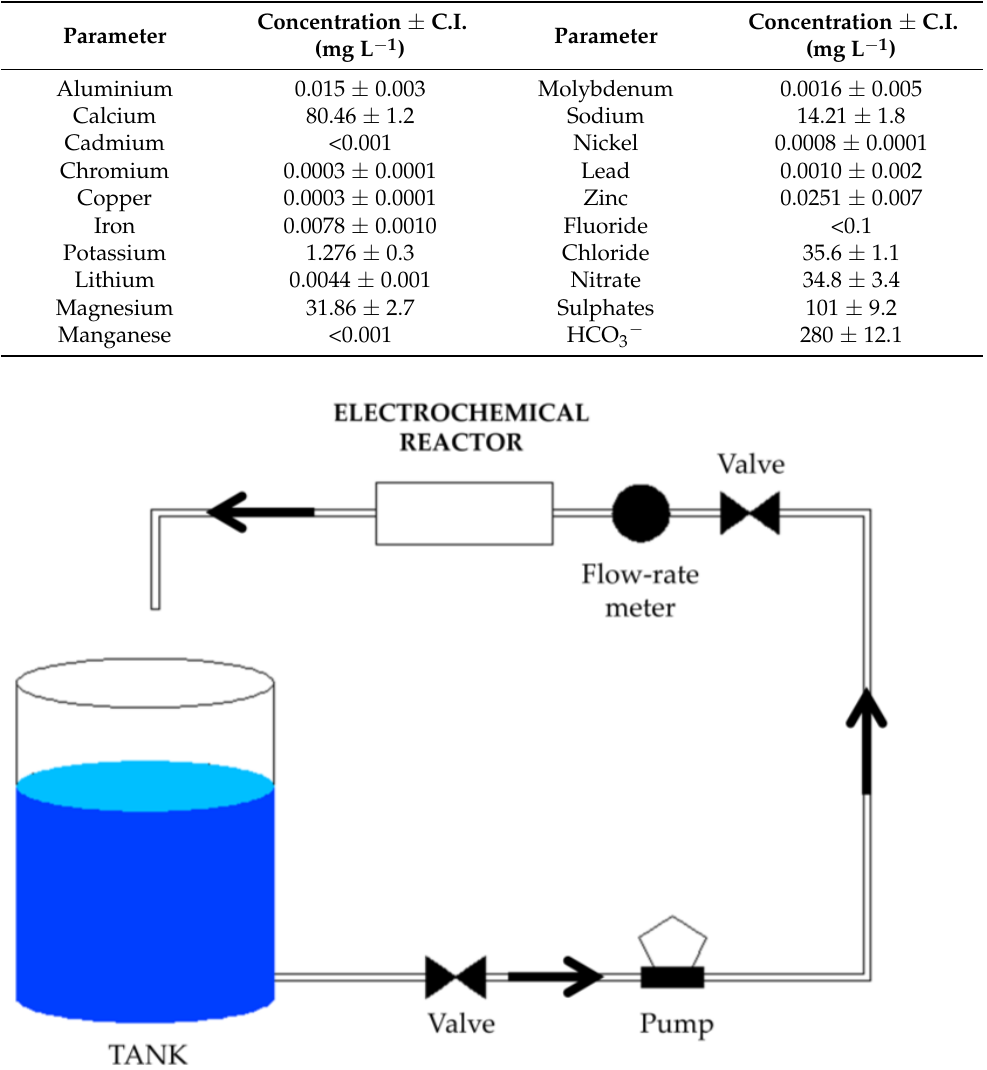
Figure 1. Experimental set-up for the electrochemical oxidation.